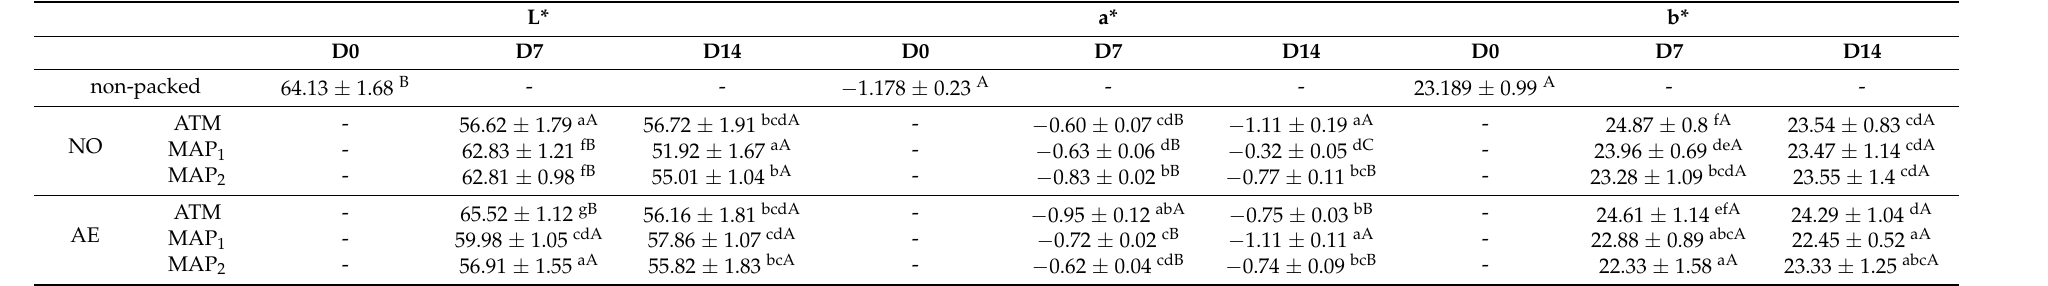
Table 3. Changes in color components L*, a*, and b* during 14-days storage of GF cake (mean ± SD; n =